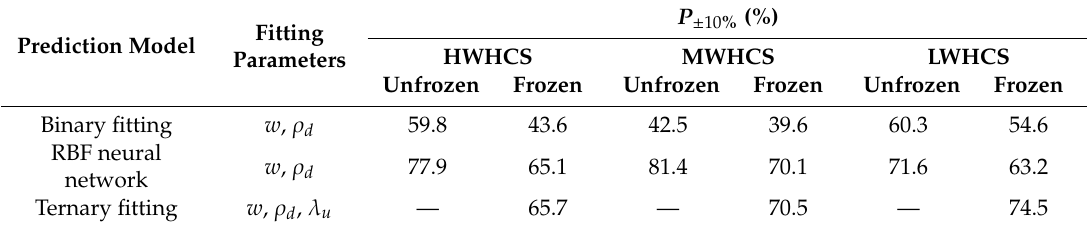
Table 7. Quantitative proportion of relative error within ± 10% for three prediction